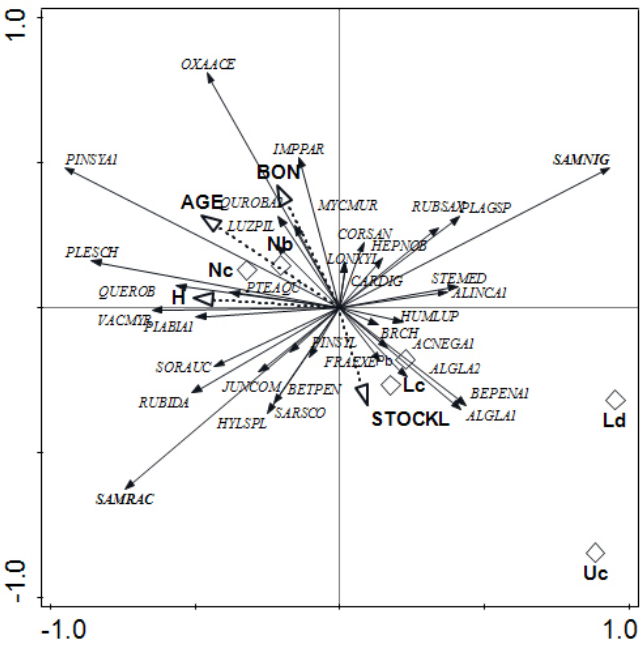
Figure 10. Principal correspondence analyses (PCoA) of non-native Sambucus racemosa , S. nigra communities; triplot showing species (arrows), dendrometric stand parameters (dashed arrows) and site types (empty diamonds). Abbreviations are: Dendrometrical parameters: STOCKL, forest stocking level; H, height; AGE, the age of forest stand; BON, bonitet (site class) of forest stands. Forest site types: Nb, fresh poor soils; Nc, fresh fertile soils; Lc,